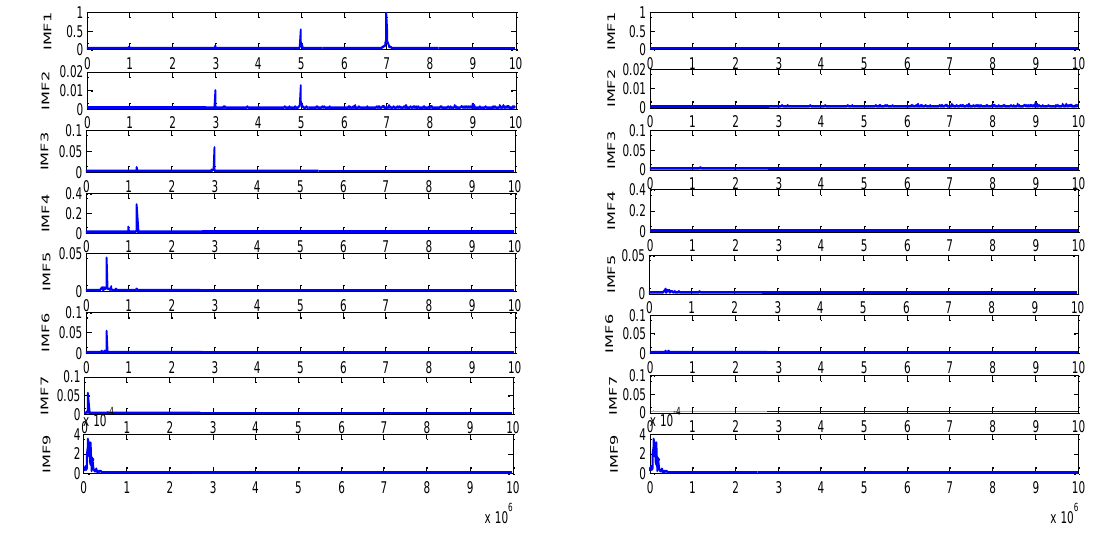
Figure 5. Frequency spectra of the eight significant IMFs detected by the proposed CEEMDAN-Hankel-SVD algorithm before the application of singular value decomposition (SVD) ( left ; reproduced here from the right side of Figure 3) and after the application of SVD ( right ).